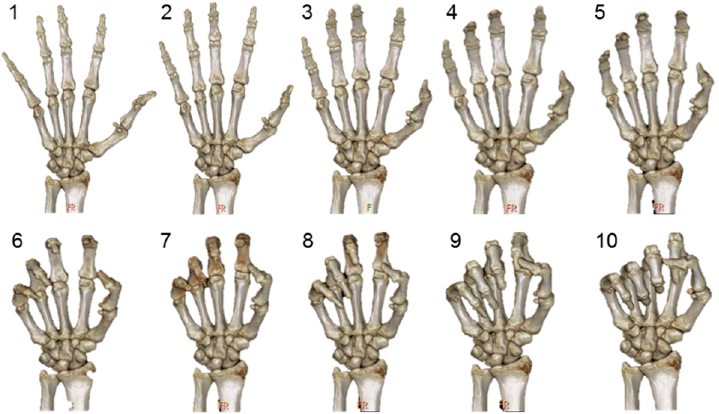
Figure 2. Postures selected from a natural hand motion starting from a fully extended posture (posture 1) to a fist posture (posture 10) for the estimation of finite finger joint centers of